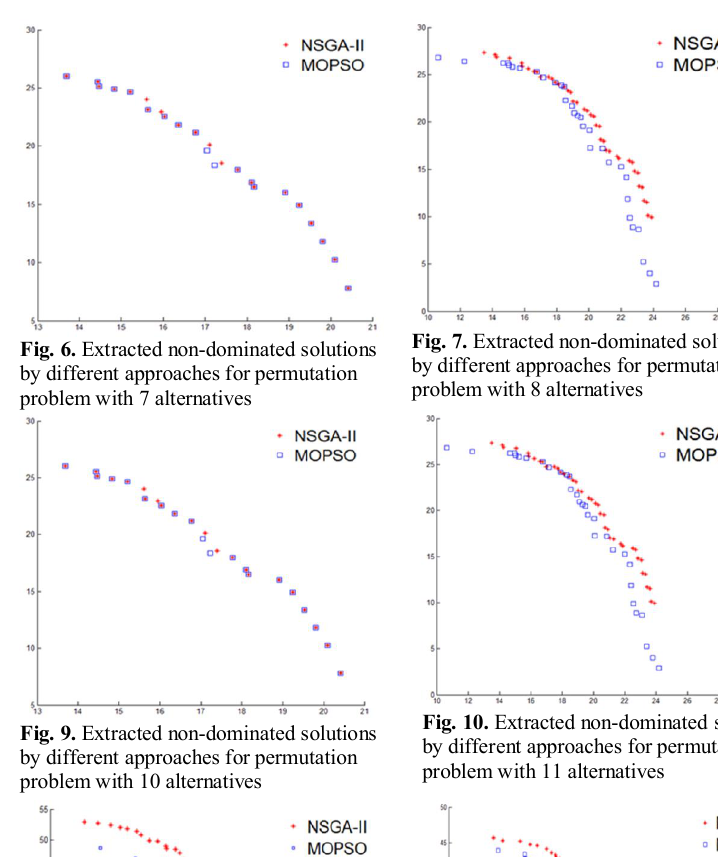
Fig. 9. Extracted non-dominated solutions by different approaches for permutation problem with 10 alternatives